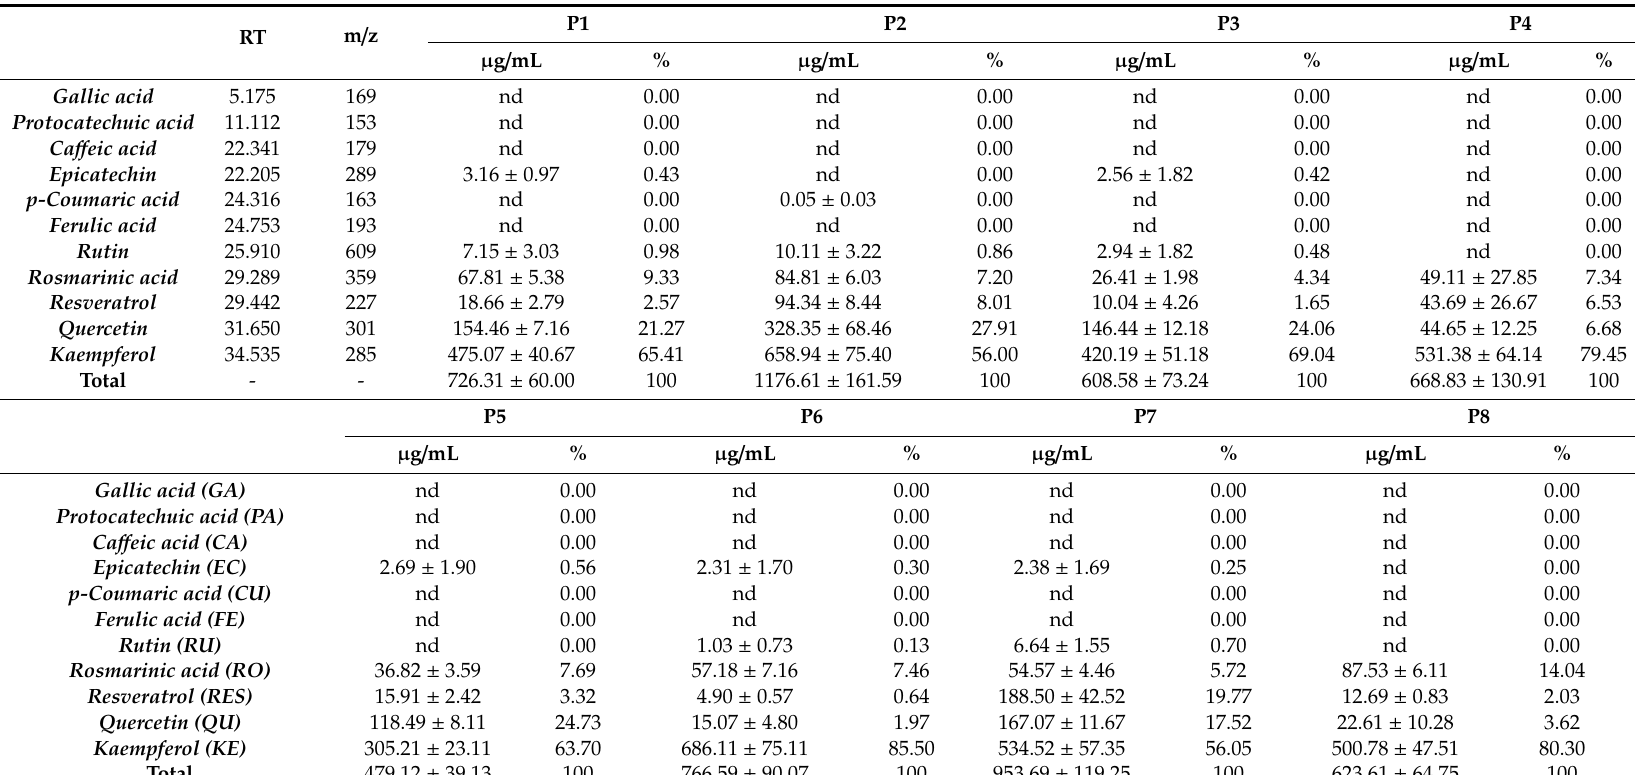
Table 1. The distribution of the polyphenolic compounds in propolis extracts (LC-MS